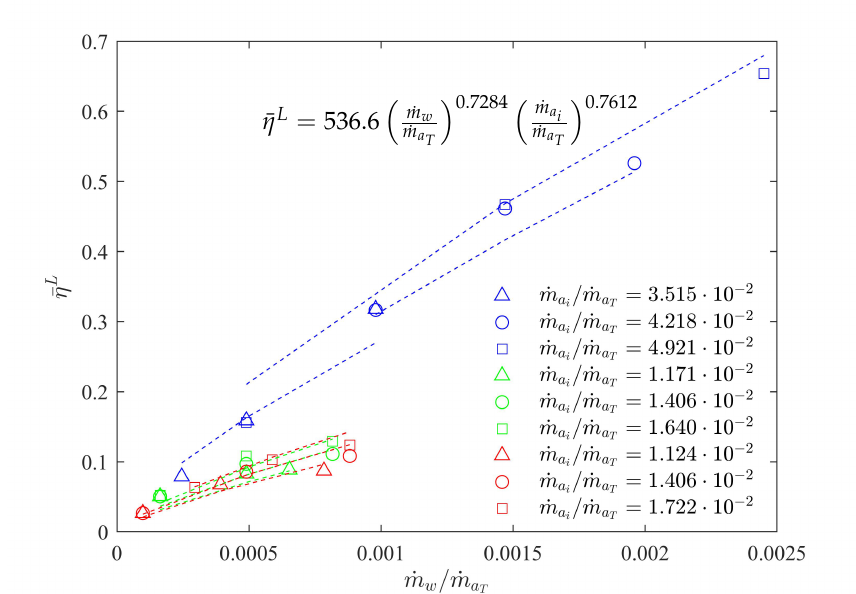
Figure 9. Evaporative cooling efficiency as a function of the water-to-air mass flow ratio for all the simulations